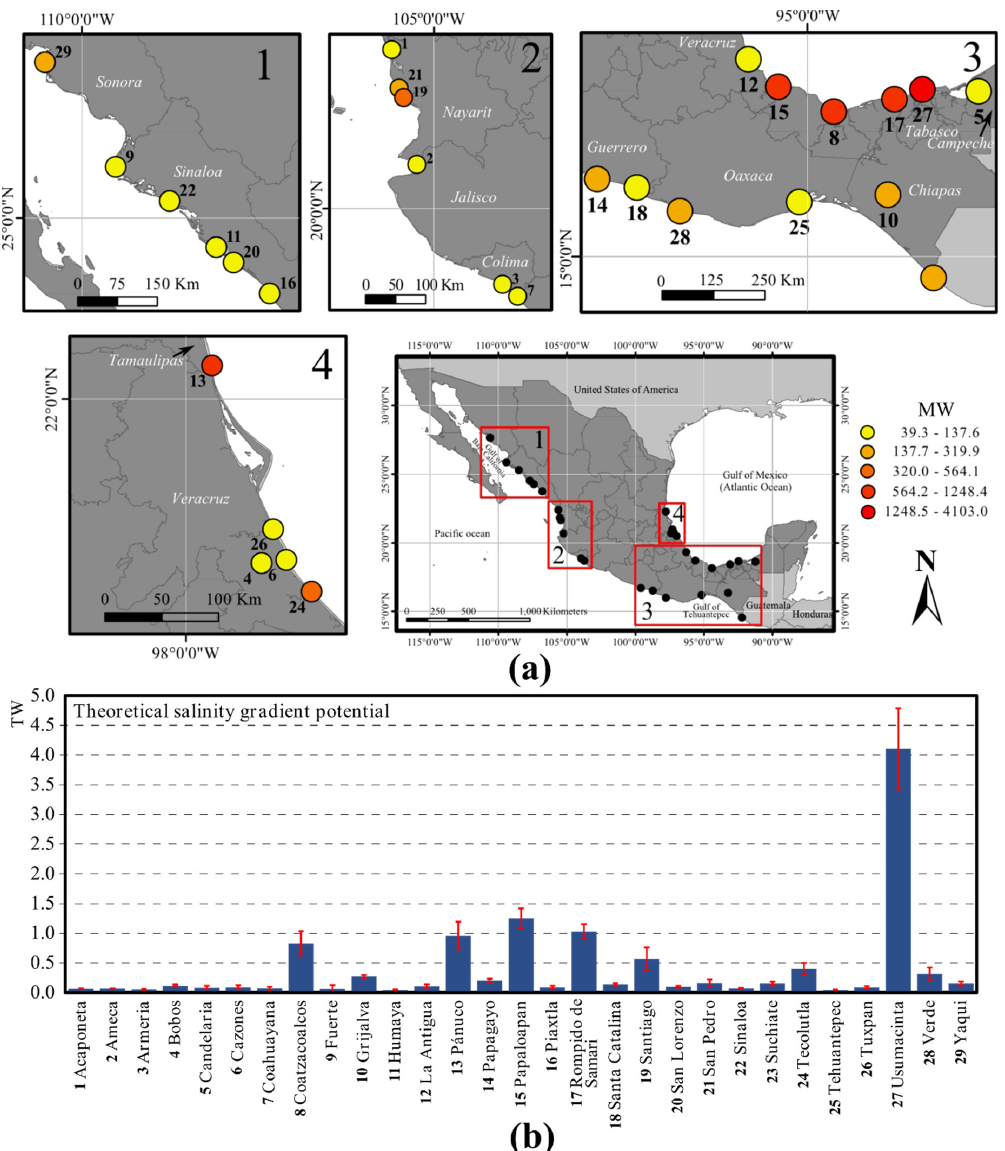
Figure 4. Theoretical estimation of power from salinity gradients in Mexico. ( a ) Theoretical power measured at 29 river station locations (in Megawatts, MW). ( b ) Annual averaged power (in Terawatts, TW), including mean and standard deviation values. It should be noted that the time period for the sampling varied for each river (details in the corresponding database).